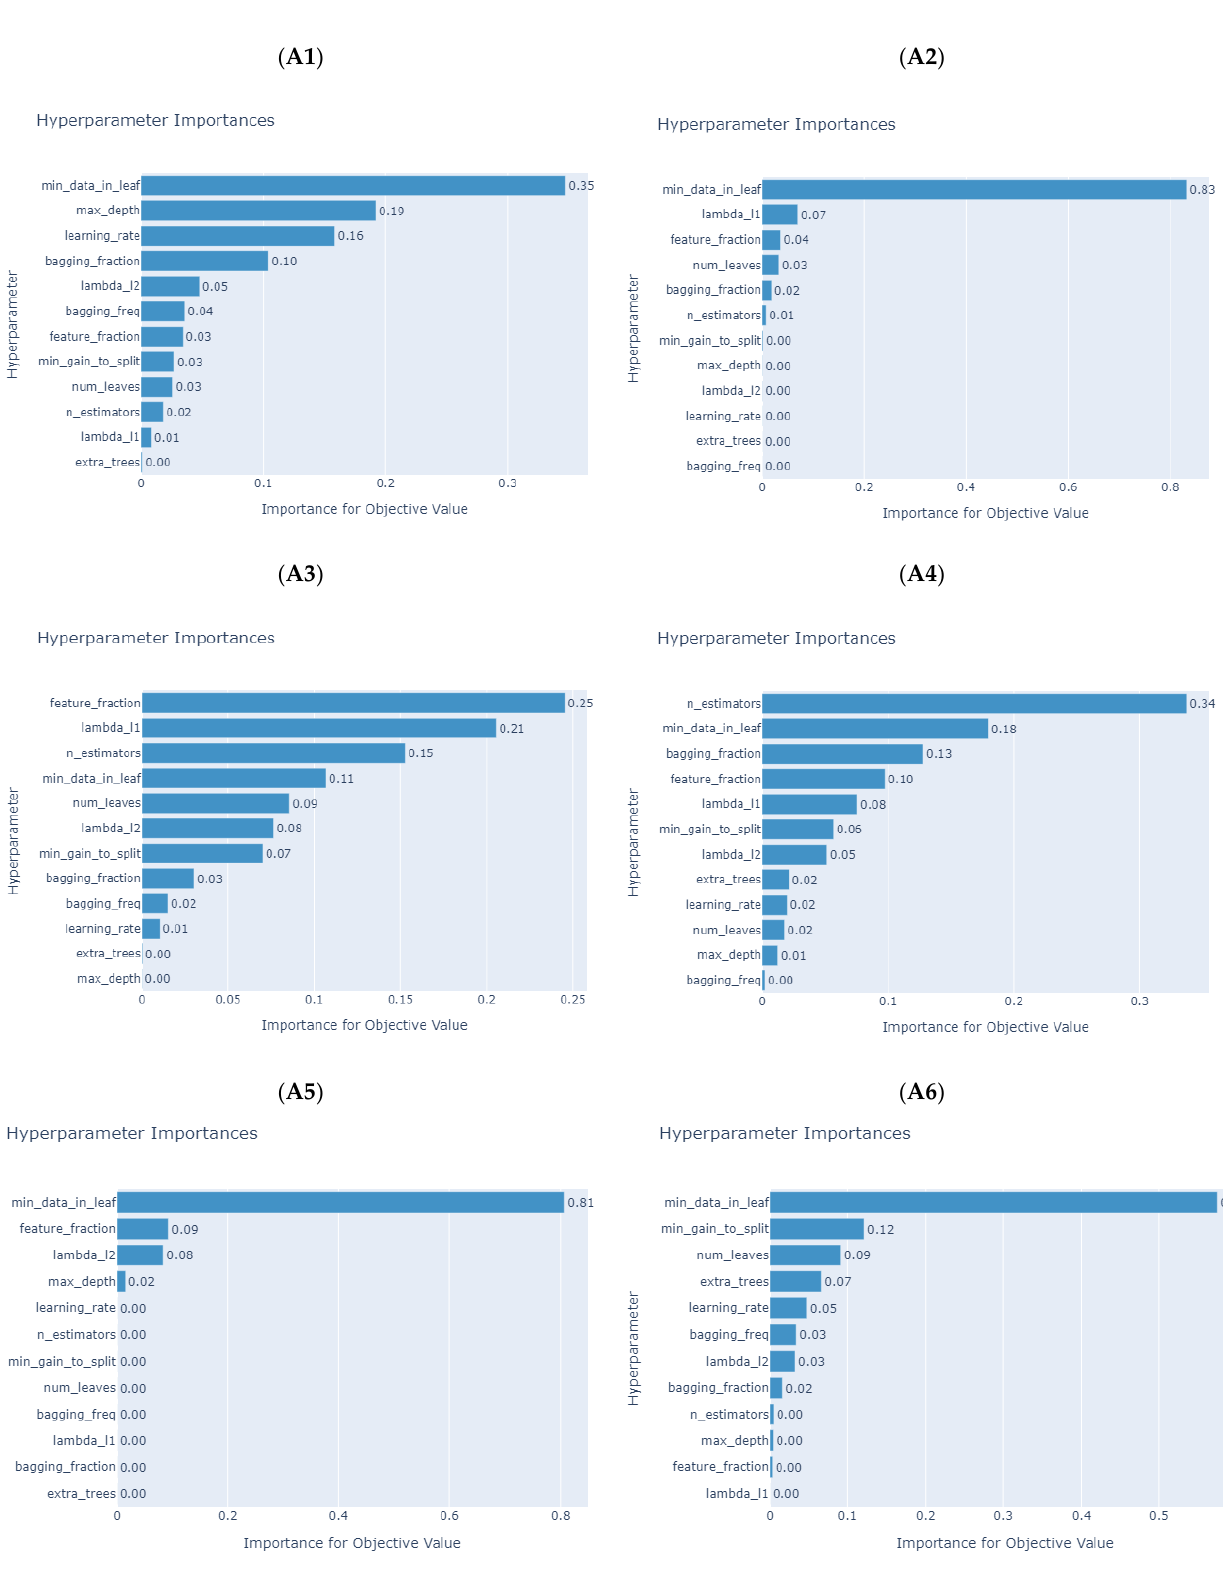
Figure 5. Hyperparameter importance of LightGBM models for product category A (product A1 – A6